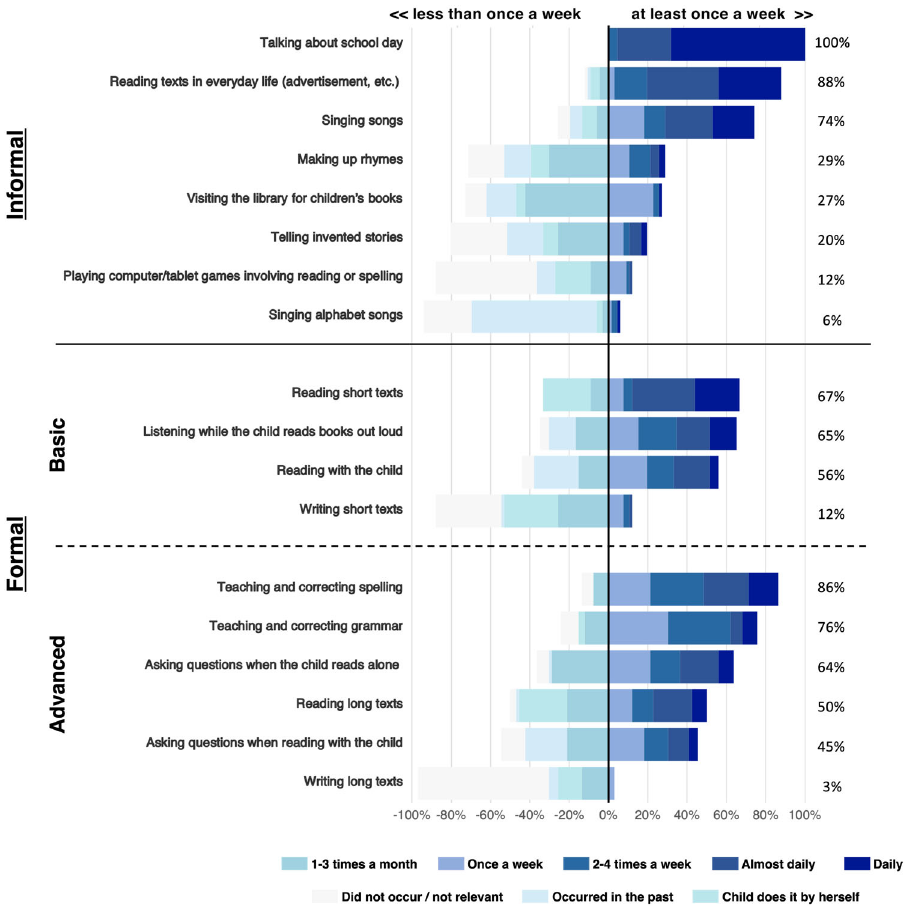
Fig. 2 Divergent stacked bar chart showing the frequencies of informal, basic formal, and advanced formal practices among parents ( n = 66). Percentages on the right indicate the share of parents who engage in each practice at least once a week. Practices are ordered from the most (top) to the least frequent (bottom) for each level of